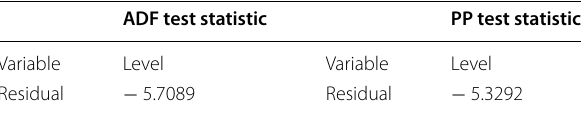
Abbreviations GDP: Gross Domestic Product; COMESA: Common Market for Eastern and Southern Africa; ECCAS: Economic Community of Central African States; ECO‑ WAS: Economic Community of West African States; SACU : Southern African Custom Union; SADC: Southern African Development Community; WTO: World Trade Organization.